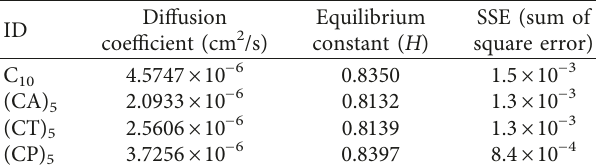
Table 2: Calculated diffusion coefficient. ID